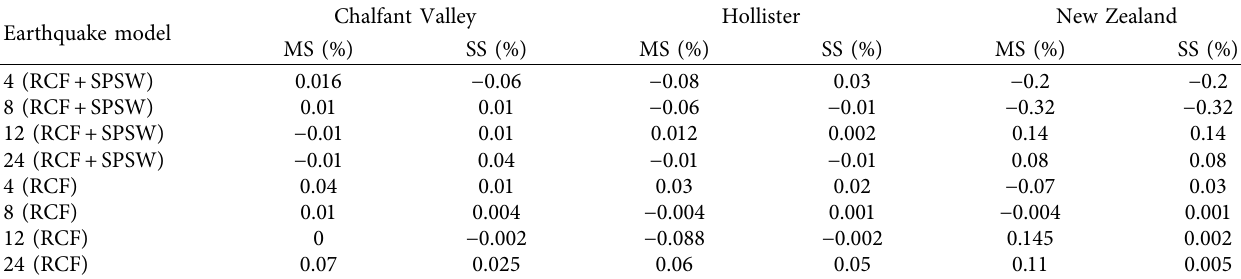
Table 16: Results of residual drift analysis of models under MS and SS of seismic scenario with maximum EPA. Earthquake model